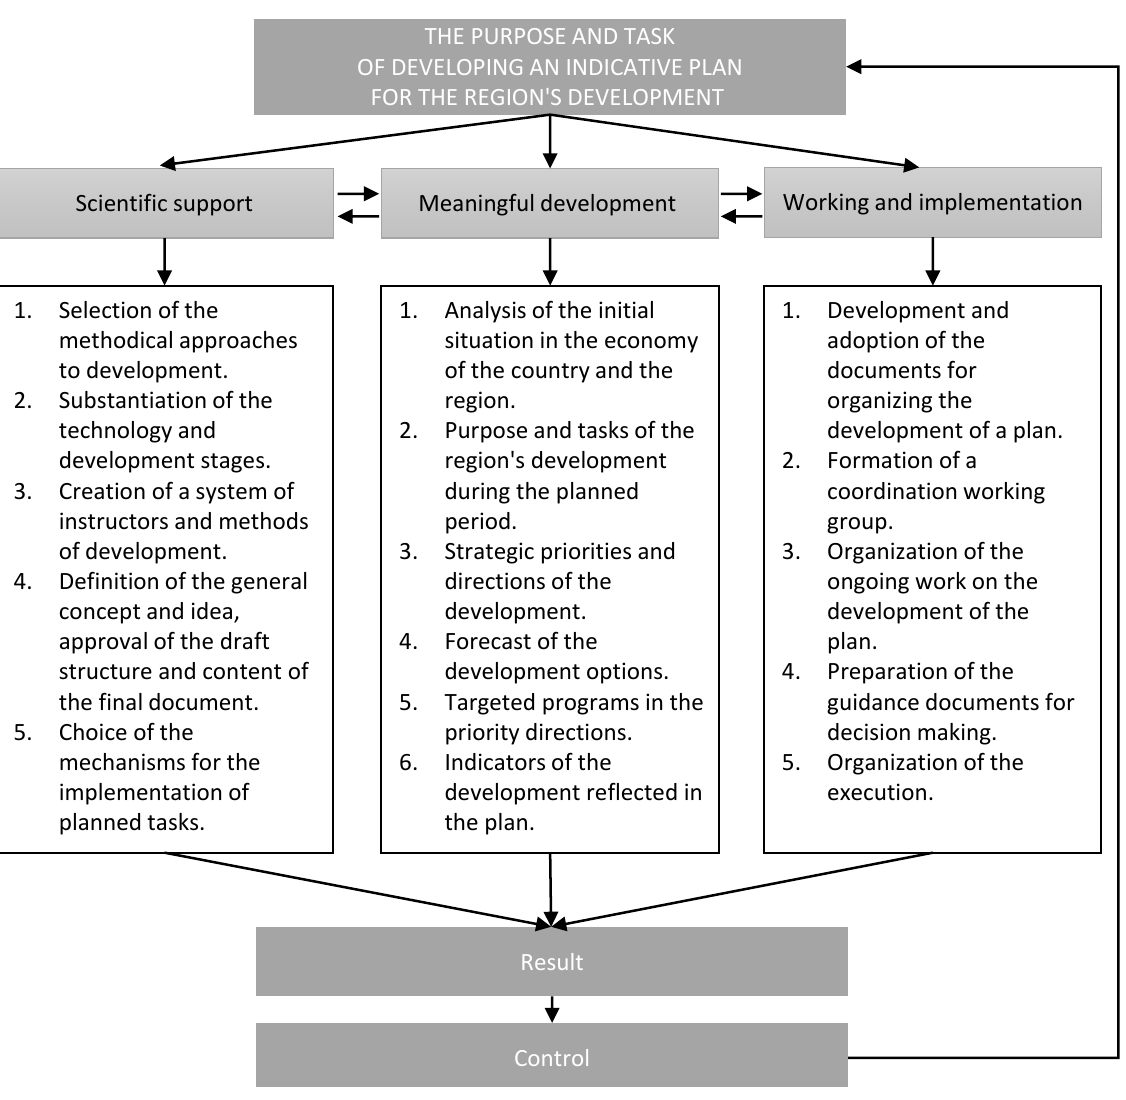
Figure 1. The structure of the development of the indicative plan for the region’s